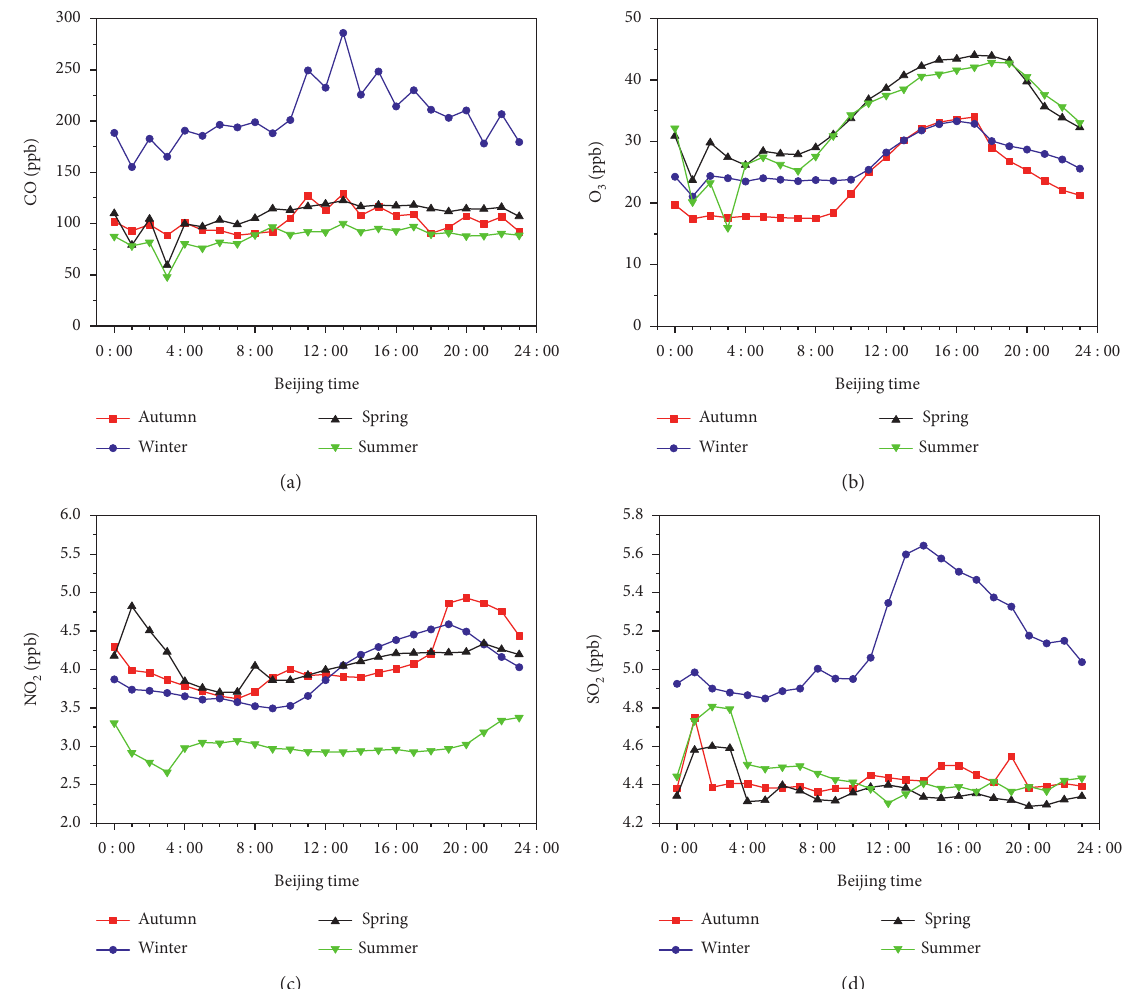
Figure 4: Average diurnal variations of reactive gases in different seasons at the Akedala background station from September 2017 to August